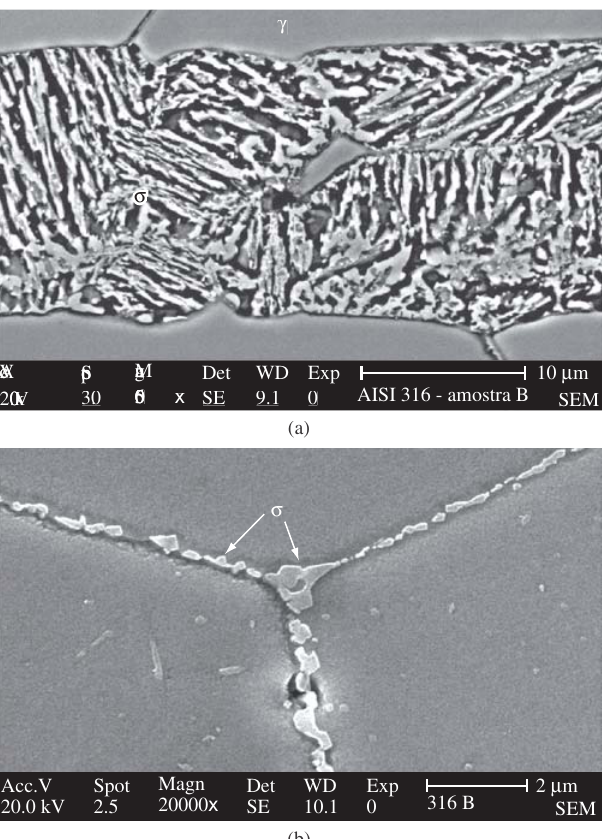
Figure 8. Flow stress curves (rupture strength after 100000 hours) vs. tem- perature for various stainless steels and superalloys 37 . Where ‘F’ means ferritic; ‘M’ means martensitic and ‘A’ means austenitic.